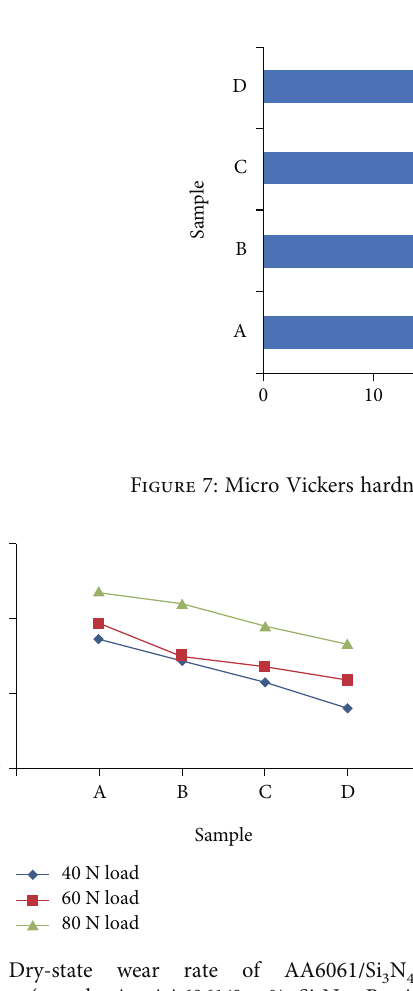
N , and D- AA6061/12 wt% Si 3 4